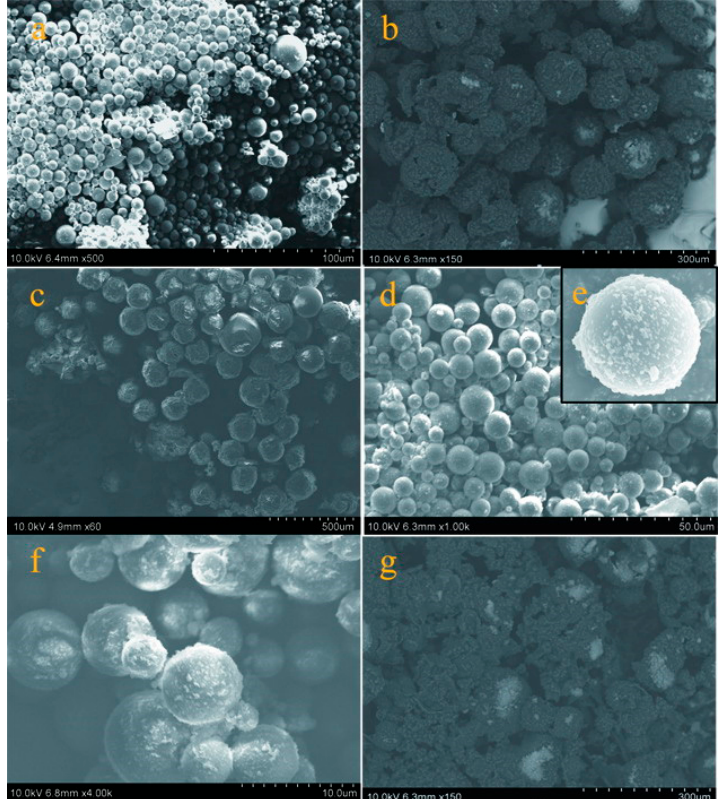
Figure 5. SEM surface morphologies of microcapsules fabricated under various pH values, ( a ) M-0, ( b ) M-3, ( c ) M-4, ( d , e ) M-5,( f ) M-6, and ( g ) M-7.